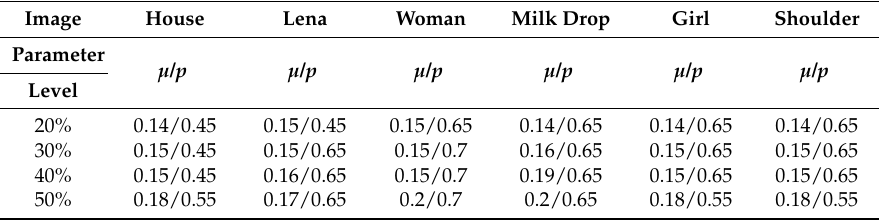
Table 1. The optimal parameters for different images with the noise level from 20% to 50%. Image House Lena Woman Milk Drop